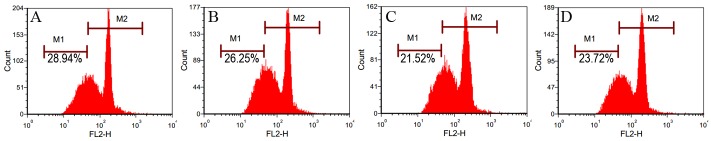
Detection of addition of vitamin E analogue to freezing extender on lipid peroxidation in the frozen-thawed rabbit spermatozoa.Sperm lipid peroxidation was analyzed by staining with BODIPY 581/591C11. Histogram shows spermatozoa with lipid peroxidation (marker M1) and without lipid peroxidation (marker M2). A: 0 μM; B: 100 μM; C: 200 μM; D: 250 μM.